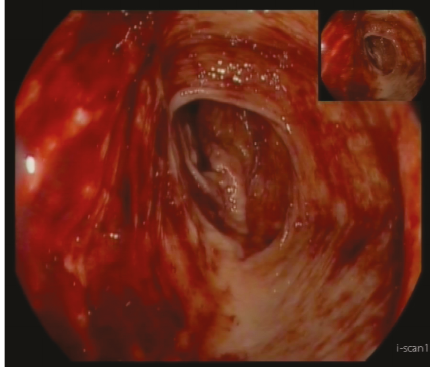
Figure 3: Lower endoscopy (hematic residues with no lesions detectable).